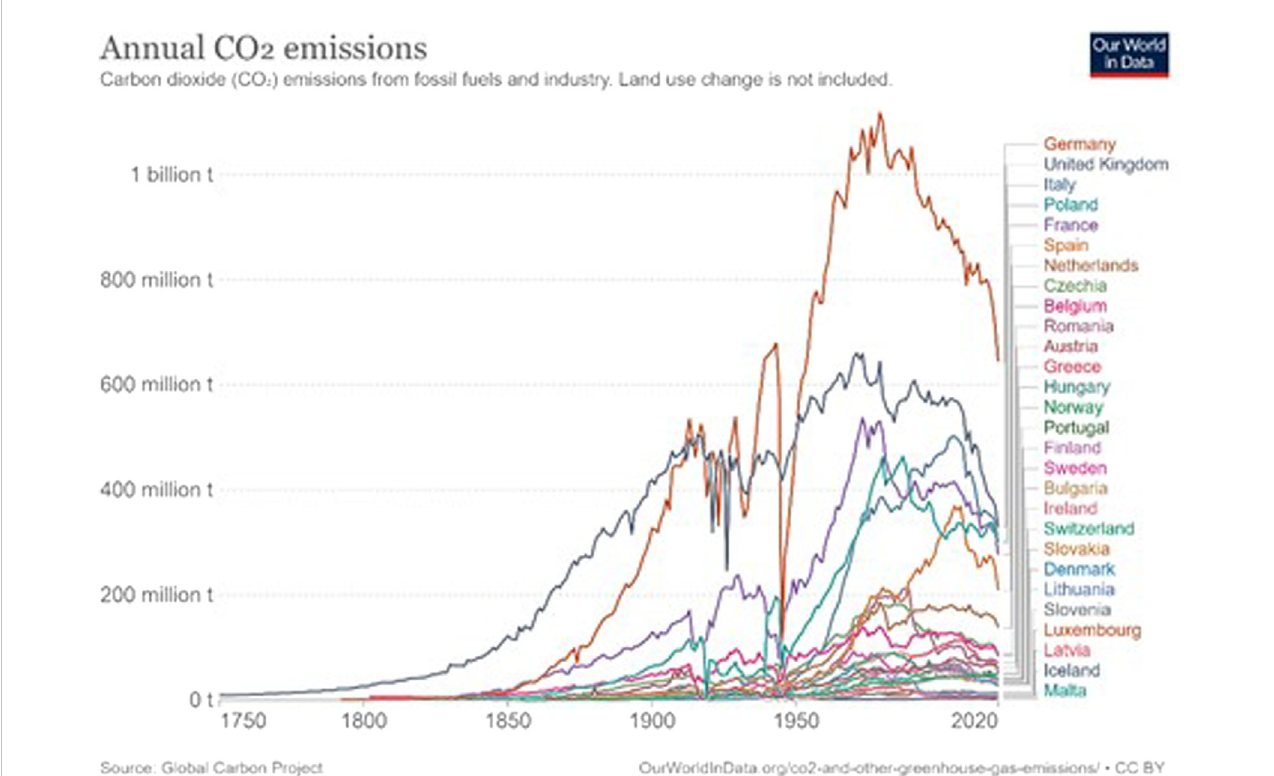
FIGURE 1 EvolutionofCO 2 emissionsforthecountriesincludedinthesampleintheperiod1750 – 2020.OwnprocessingafterGlobalCarbonProject(Ritchieetal.,